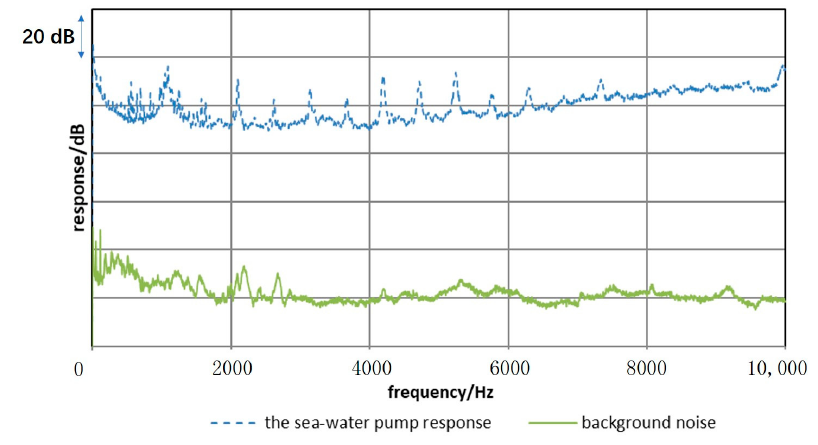
Figure 8. Signal-to-noise ratio of the sea-water pump vibration response at 1710 r/min.